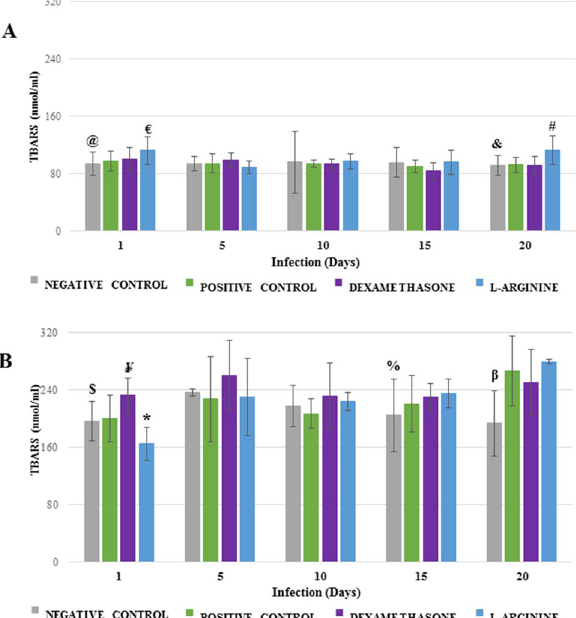
Figure 4. Thiobarbituric acid reactive substances (TBARS) in the lungs ( A ) and brains ( B ) of Plasmodium berghei -infected Swiss mice. Animals were pretreated and received a daily dose of DEXAMETHASONE, L-ARGININE, or PBS (CONTROL). @ p = 0.0212 versus L-ARGININE; € p = 0.0294 versus POSITIVE CONTROL; & p = 0.0304 versus L-ARGININE; # p = 0.0282 versus DEXAMETHASONE; $ p = 0.0023 versus DEXAMETHASONE; ¥ p = 0.0060 versus POSITIVE CONTROL; *p = 0.0005 versus DEXAMETHASONE and p = 0.0029 versus POSITIVE CONTROL; % p = 0.4106 versus L-ARGININE; β p = 0.0175 versus DEXAMETHASONE and p = 0.0.0169